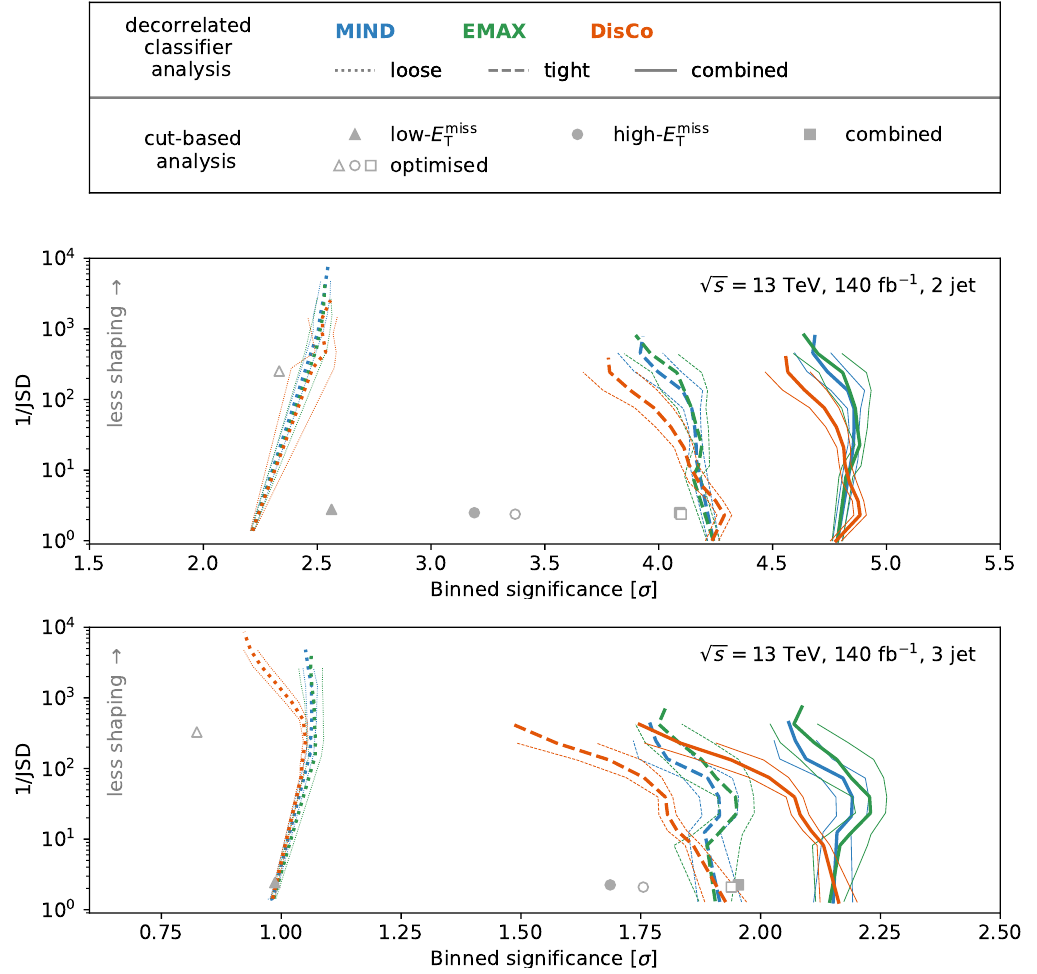
Figure 4 . Comparison of performance achieved by various DCA methods and the CBA in the two-jet (top) and three-jet (bottom) categories. The horizontal axis shows the binned signi(cid:12)cance estimate. The vertical axis shows the inverse of the Jensen-Shannon divergence (1 = JSD) between the m bb distributions of the combined background in individual analysis categories and the inclusive case. For the combination of two categories, 1 = JSD between the background distribution in the tight (high- E miss ) category and the inclusive distribution is plotted for DCA (CBA). The thick lines T indicate the average binned signi(cid:12)cances achieved at a certain level of 1 = JSD and the thin lines correspond to their sample standard deviations. For each method, around 500 models are trained with various values of (cid:21)